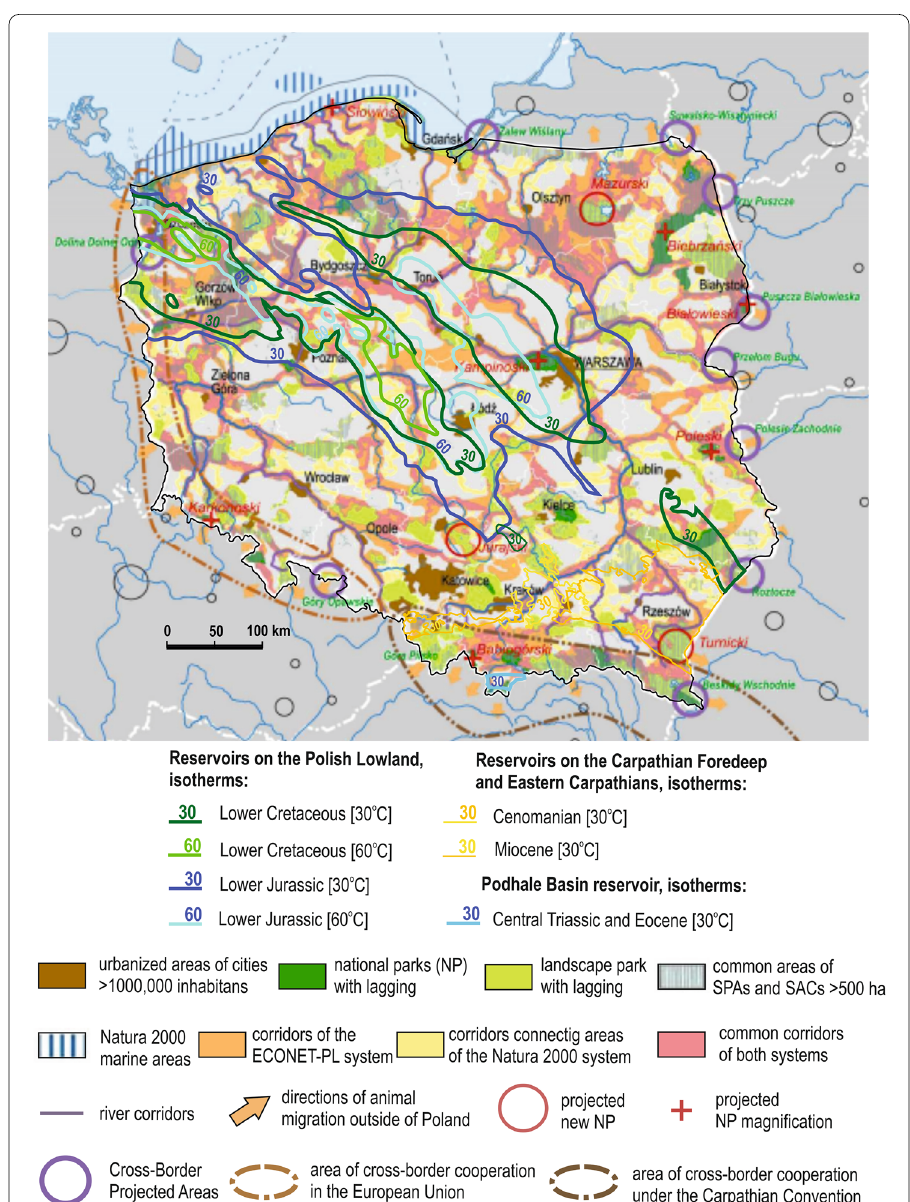
Fig. 7 Geothermal water reservoirs proposed for agricultural uses in Poland against the map of spatial policy directions concerning nature. Scientific description based on Barbacki et al. (2016) ; ranges of reservoirs with temperatures > 30 ◦ C and > 60 ◦ C according to maps by Górecki et al. (2006, 2011, 2012, 2013); underlay Żuber et al. (2021) including network status in 2010, Helcom BSPA data on sea areas, data of the Institute of Environmental Protection about corridors ECONET‑PL in 1996, data of the Mammal Research Institute, Polish Academy of Sciences, Bialowieza, about the corridors connecting Natura 2000 areas in 2006 and data of the National Water Management Board on river corridors in